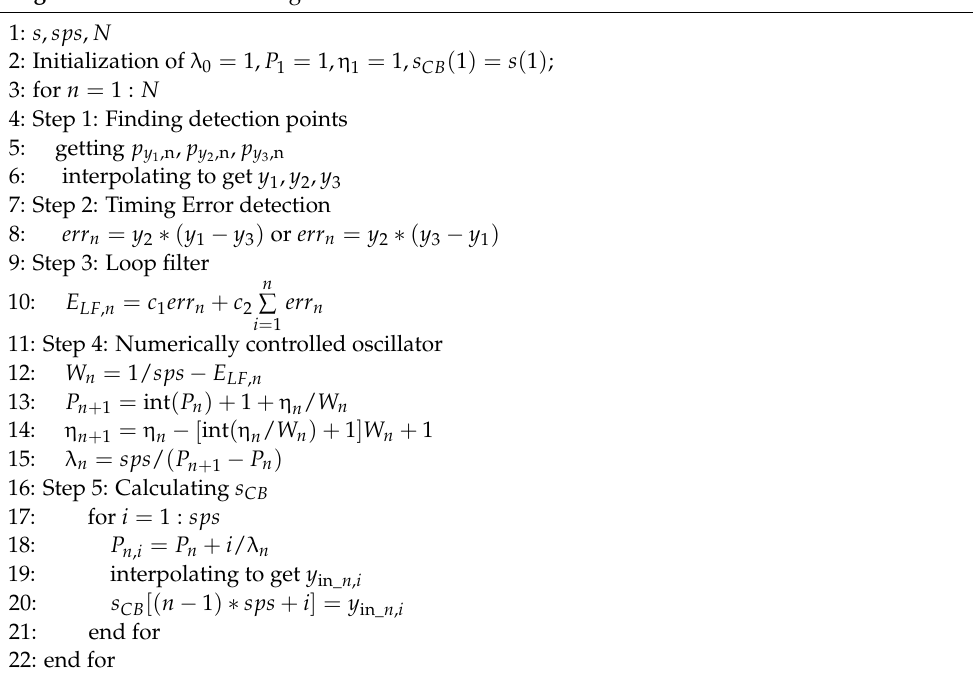
Algorithm 1: CB-Gardner